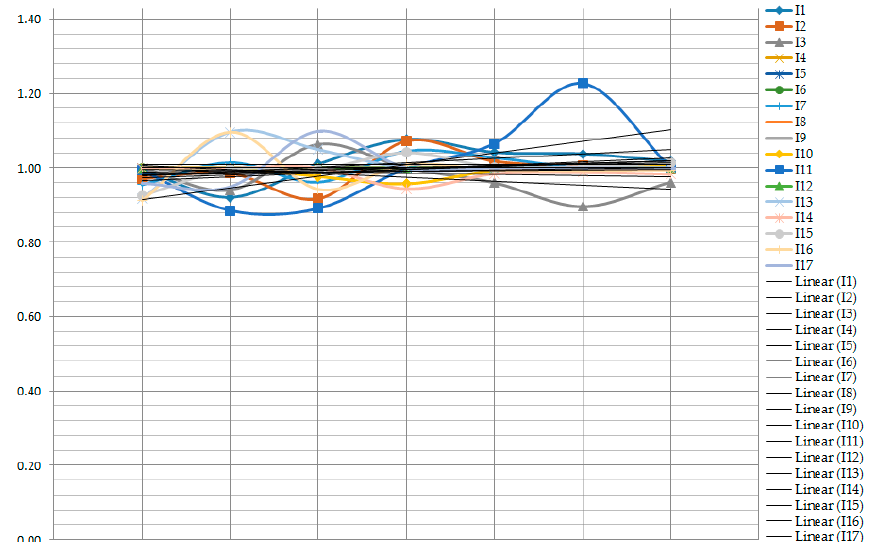
Figure 3. Catch-up index.